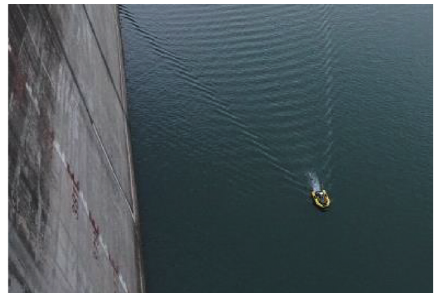
Figure 7: The field working picture of USV.